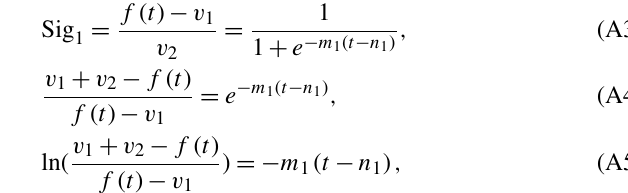
Figure A1. Illustration of the double logistic model and corre- sponding parameters. EVI: enhanced vegetation index; DOY: day of